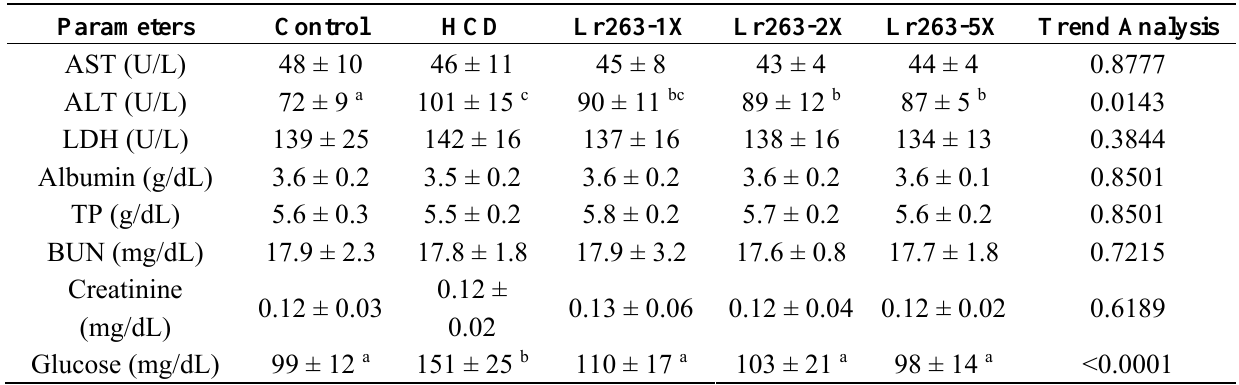
Table 3. Biochemical analysis of the L. reuteri 263 (Lr263) treatment groups at the end of experiment. Parameters